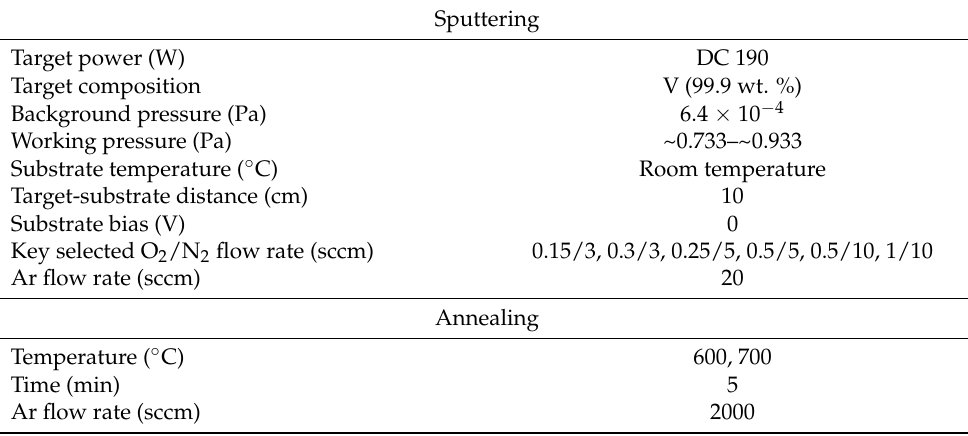
Table 2. Process parameters for sputtering and rapid thermal